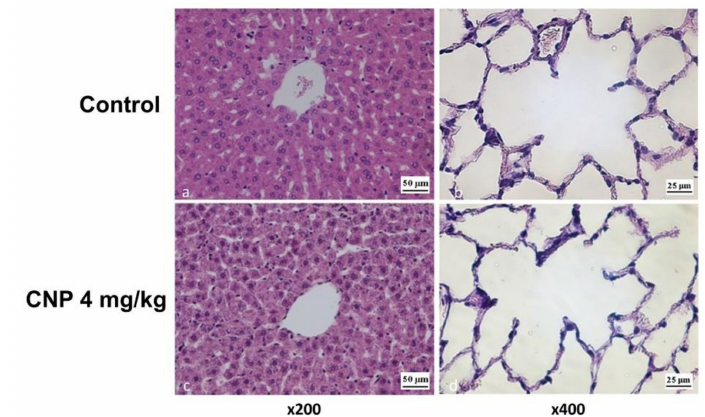
Figure 11. The histological pattern of rat organs at 14 days after a single injection of a CNP-4 suspension (4 mg / kg). Tissues were stained with hematoxylin /